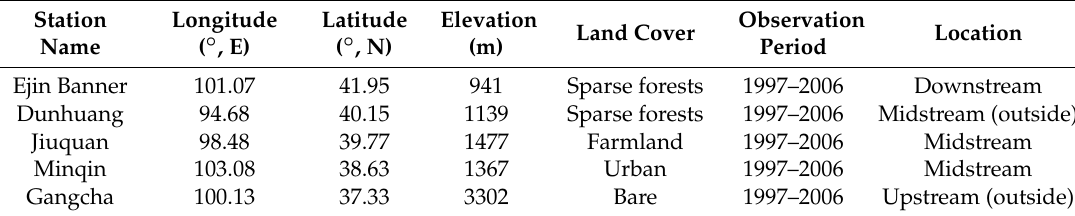
Table 2. National radiation station information for the Heihe River